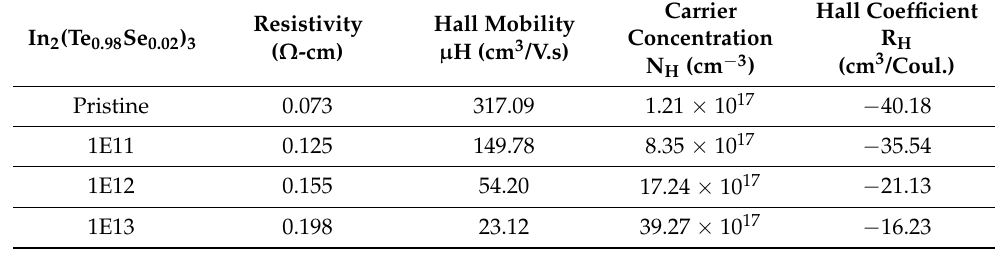
Figure 7. Electrical resistivities ( ρ ) of pristine and irradiated In 2 (Te 0.98 Se 0.02 ) 3 films.